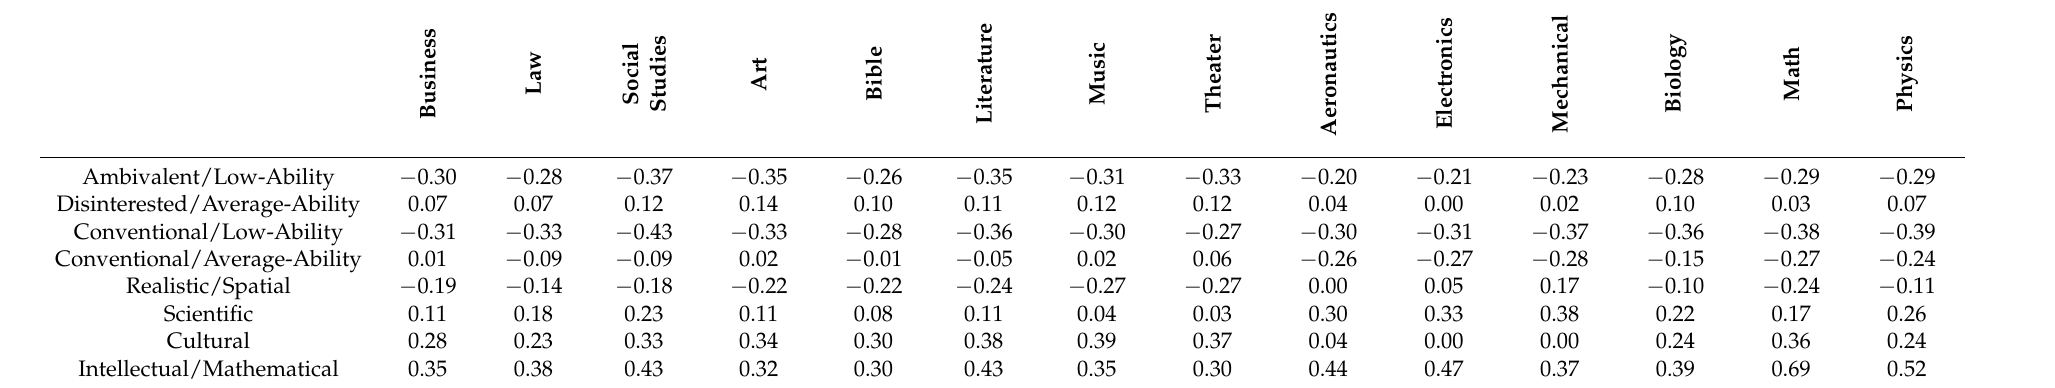
Table 5. Standardized Beta Coefficients from Regressing Knowledge Domains on